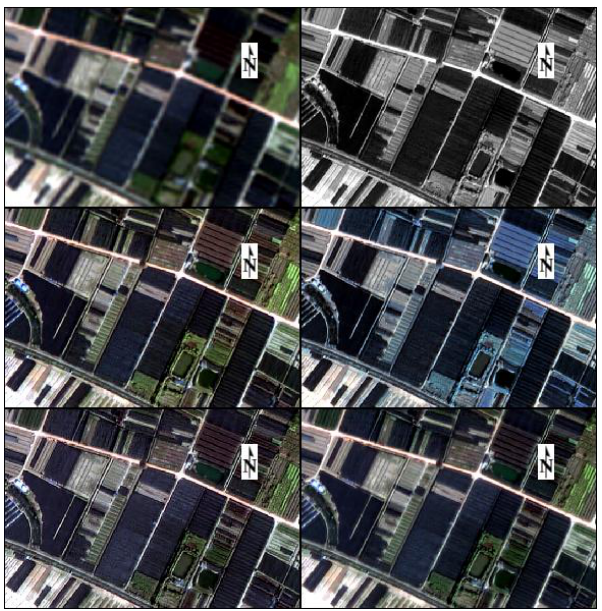
Figure 4. The fused images with different methods of GF-2 image over the cropland. From left to right, up and down: MS; PAN; GS; NND; UNB and the proposed method.